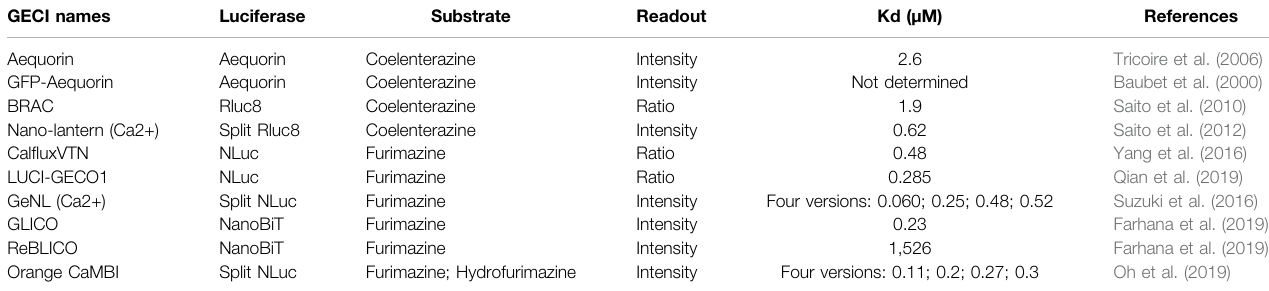
TABLE 1 | Summary of properties of bioluminescent